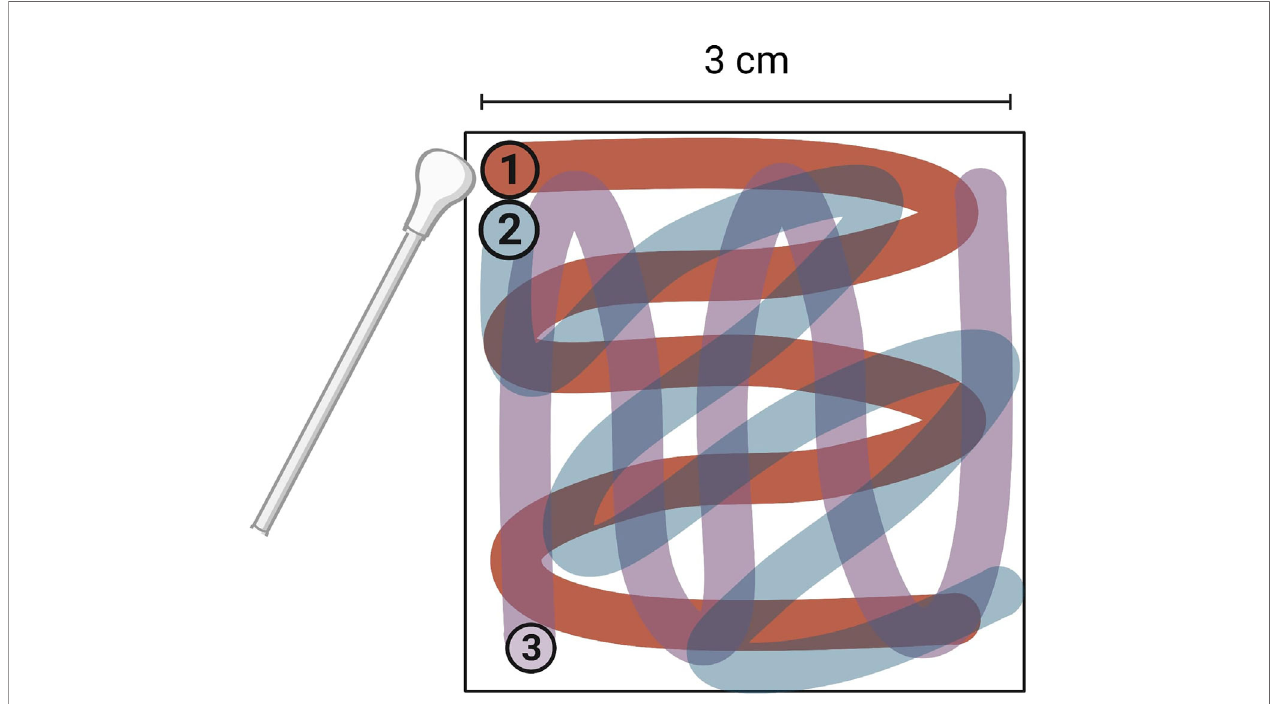
FIGURE 2 | Direction and order of swabbing on surfaces tested for human norovirus swab recovery. Entire 3 cm 2 surface was swabbed. Image created with